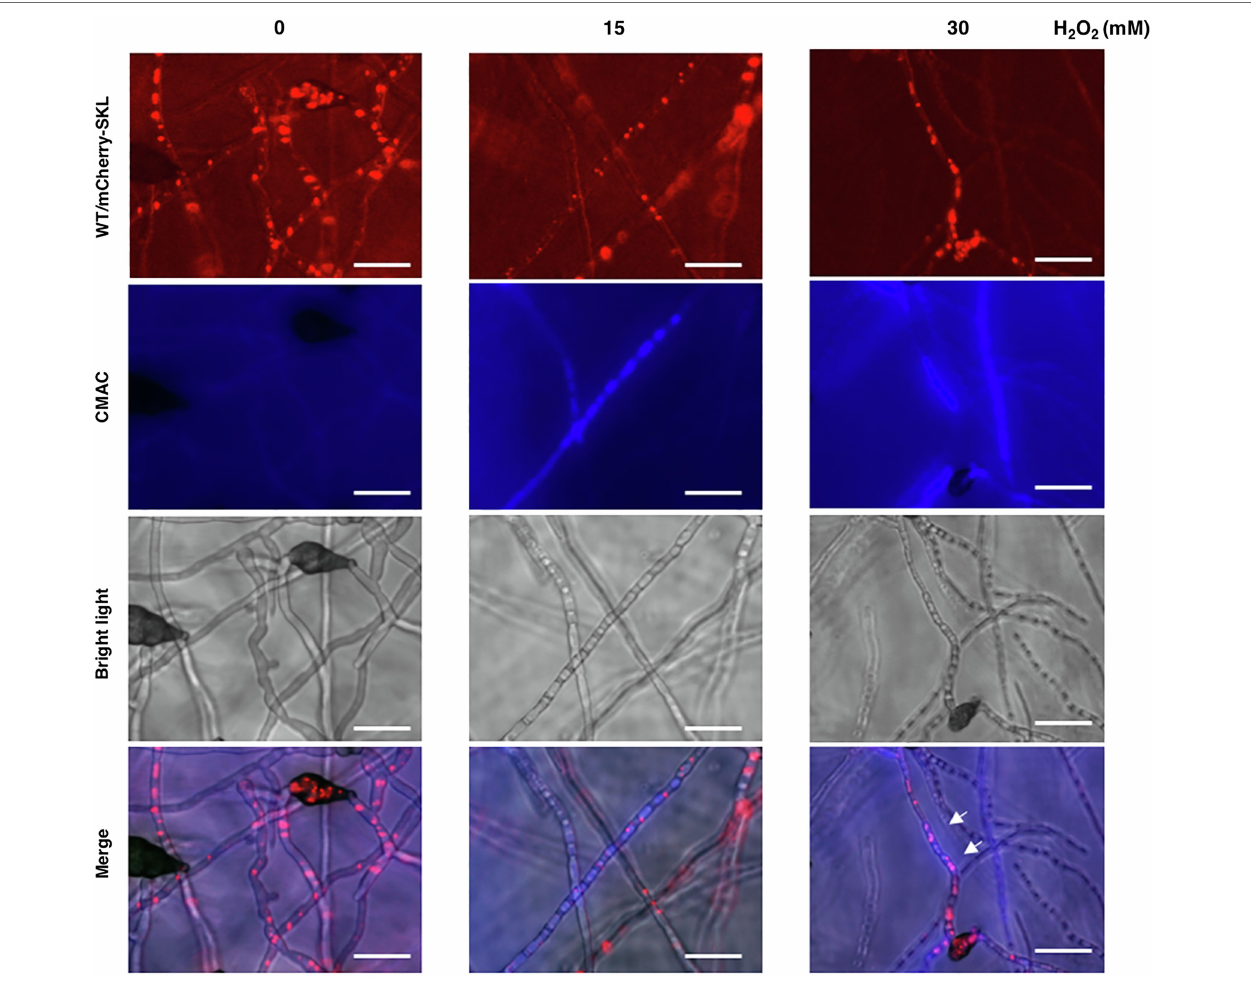
FIGURE 10 | The peroxisomal reporter protein mCherry-SKL is degraded in vacuoles. The wild-type strain expressing mCherry-SKL was treated with different concentrations of H 2 O 2 in PDB for 4 h, stained with CMAC, and observed by a fluorescent microscope. Co-localization of the mCherry-SKL proteins with vacuoles (indicated by arrows) was observed. The decrease of mCherry-SKL fluorescence was closely correlated with the increase of blue fluorescence emitted from CMAC, implicating the degradation of peroxisomes in vacuoles. Bar = 25 μ